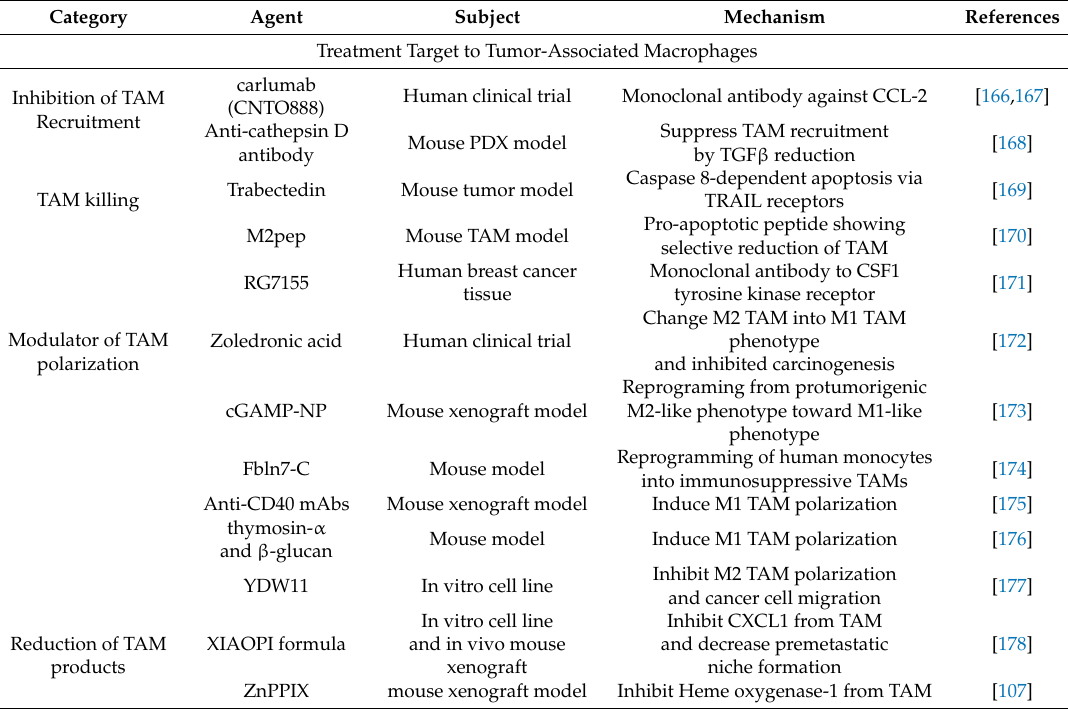
Table 2. Treatment target to tumor-associated myeloid cells for breast